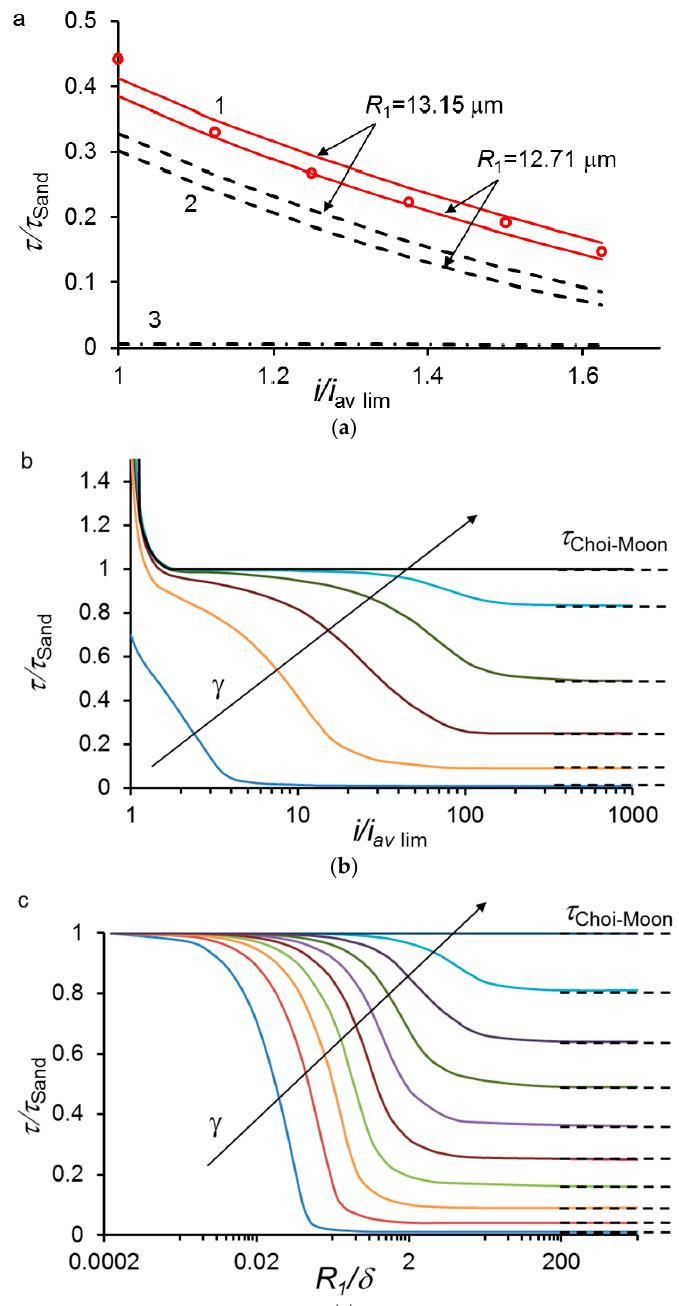
Figure 16. Transition time normalized by τ Sand as a function of ( a ) i / i av lim : experimental results (circles) are compared with the simulation using the 3D model [303] with integral current condition (77) (curve 1) or condition [274] (80) (curve 2) and the Choi-Moon theory [291], Equation (81), (curve 3), R 2 = 46.53 µ m; ( b ) i / i av lim at different fraction of conductive area γ = 0.1;0.3; 0.5;0.7;0.9; 1.0; R 1 = 12.71 µ m; ( c ) R 1 / δ at different γ (the same as in b) at fixed i = 2 i av lim ; ( b , c ) are computed using the 3D model [303] with condition (77). The dashed straight lines show the transition time calculated by the Choi-Moon Equation (81). In all cases δ = 260 µ m, i av lim = 19.74 A/m 2 . Reproduced with permission from [303], American Chemical Society,